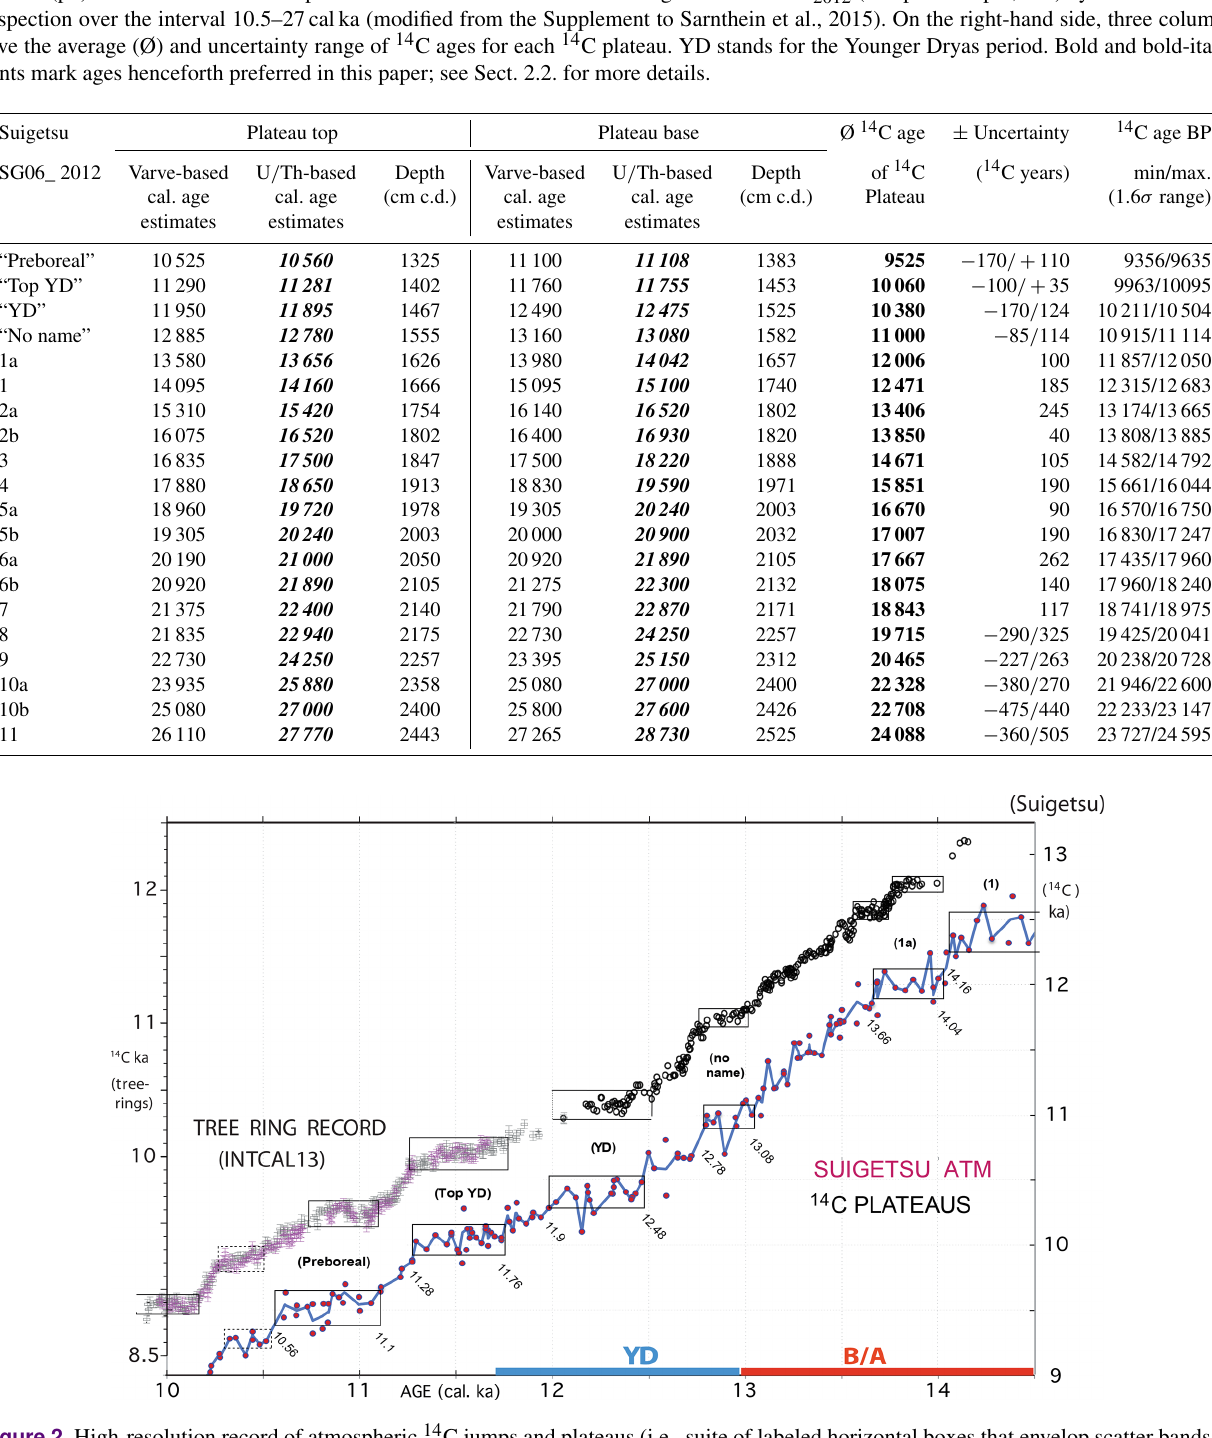
Figure 2. High-resolution record of atmospheric 14 C jumps and plateaus (i.e., suite of labeled horizontal boxes that envelop scatter bands of largely constant 14 C ages extending over > 300calyr) in a sediment section of Lake Suigetsu vs. tree-ring-based 14 C jumps and plateaus 10– 14.5calka (Reimer et al., 2013). The blue line averages paired double and triple 14 C ages of Suigetsu plant macrofossils. Age control points (calka) follow varve counts (Schlolaut et al., 2018) and U / Th-model-based ages of Bronk Ramsey et al. (2012). YD stands for Younger Dryas, and B/A stands for